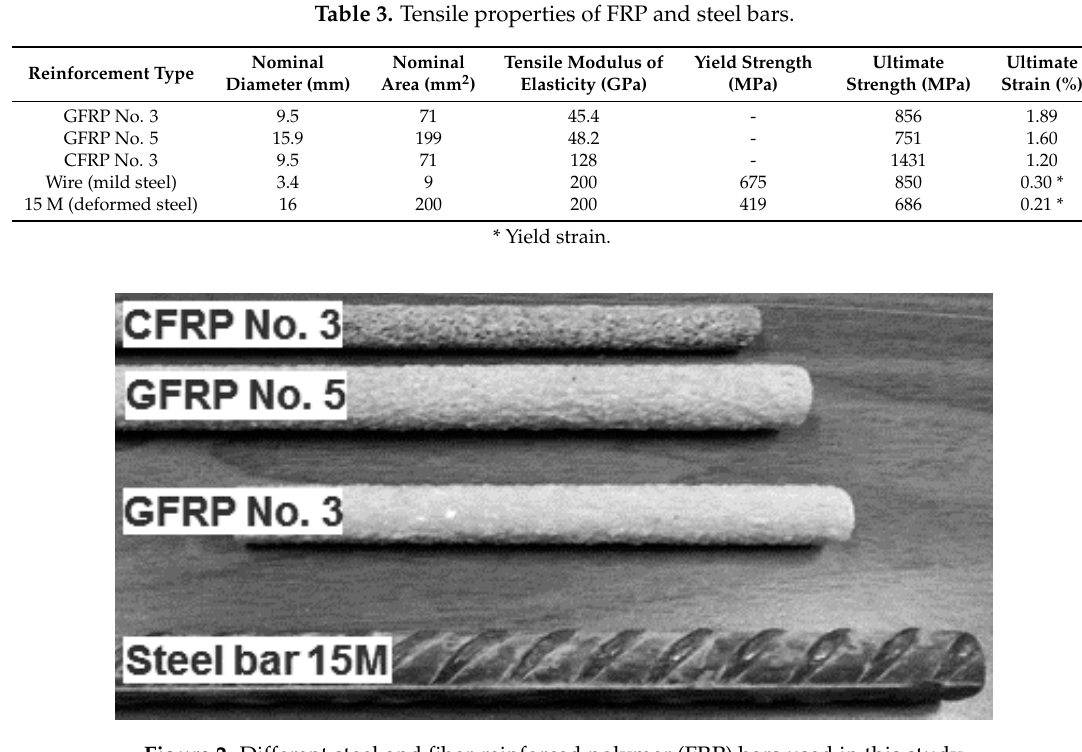
Table 3. Tensile properties of FRP and steel bars.